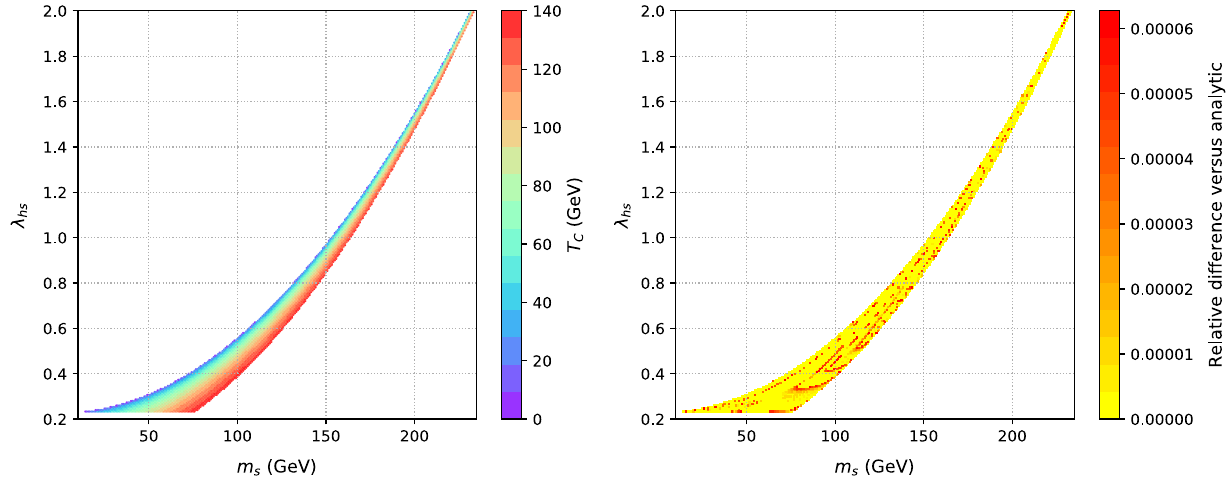
Fig. 4 The critical temperature, T C , as a function of λ hs and m s in the Z 2 SSM calculated by PhaseTracer (left) and the relative difference versus the analytic result (right). There is no FOPT in the white